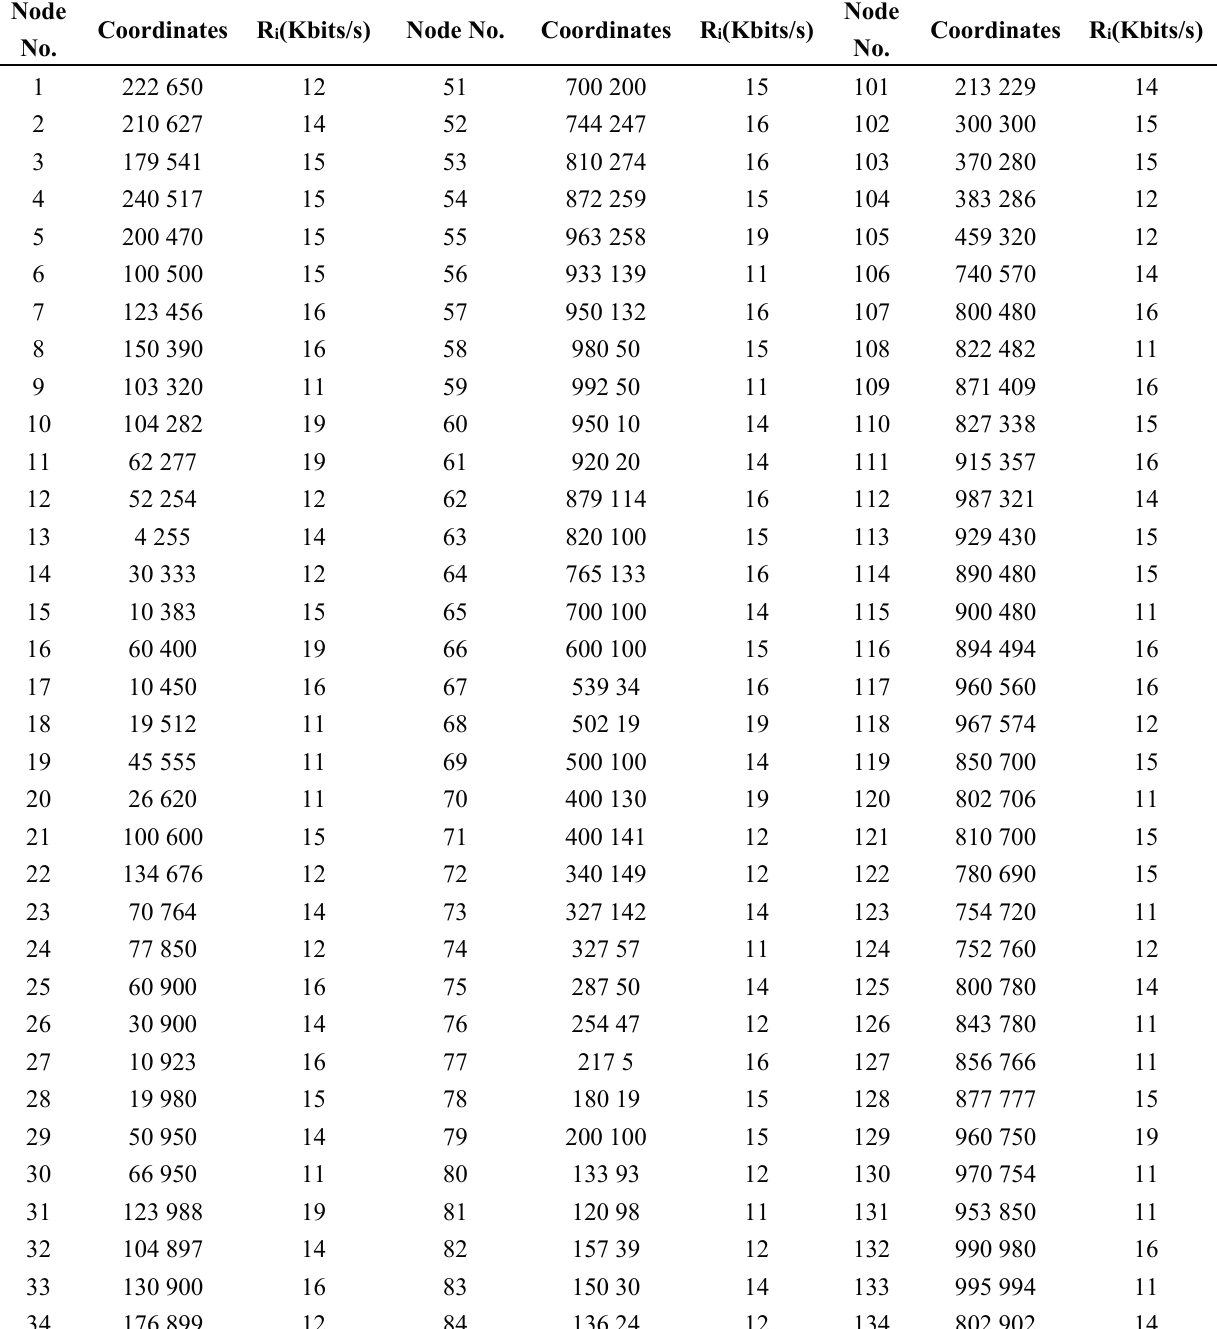
Table 2. Features of sensor